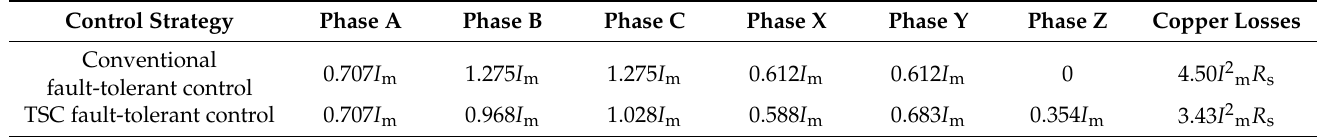
Table 1. The RMS value of the phase current and the copper losses under different control methods. Control